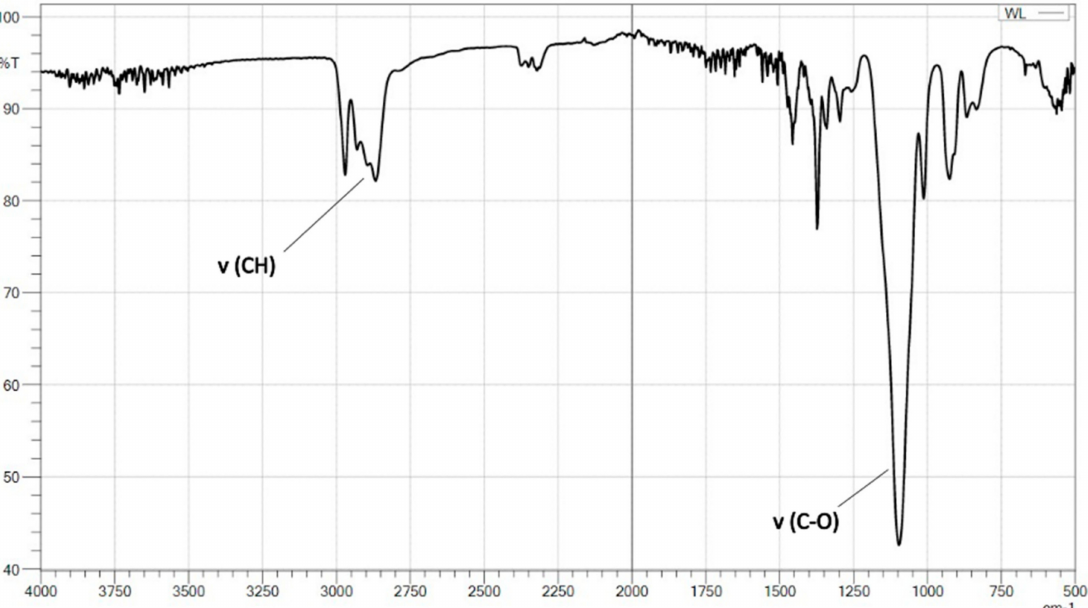
Figure 3. FTIR spectra of star-shaped